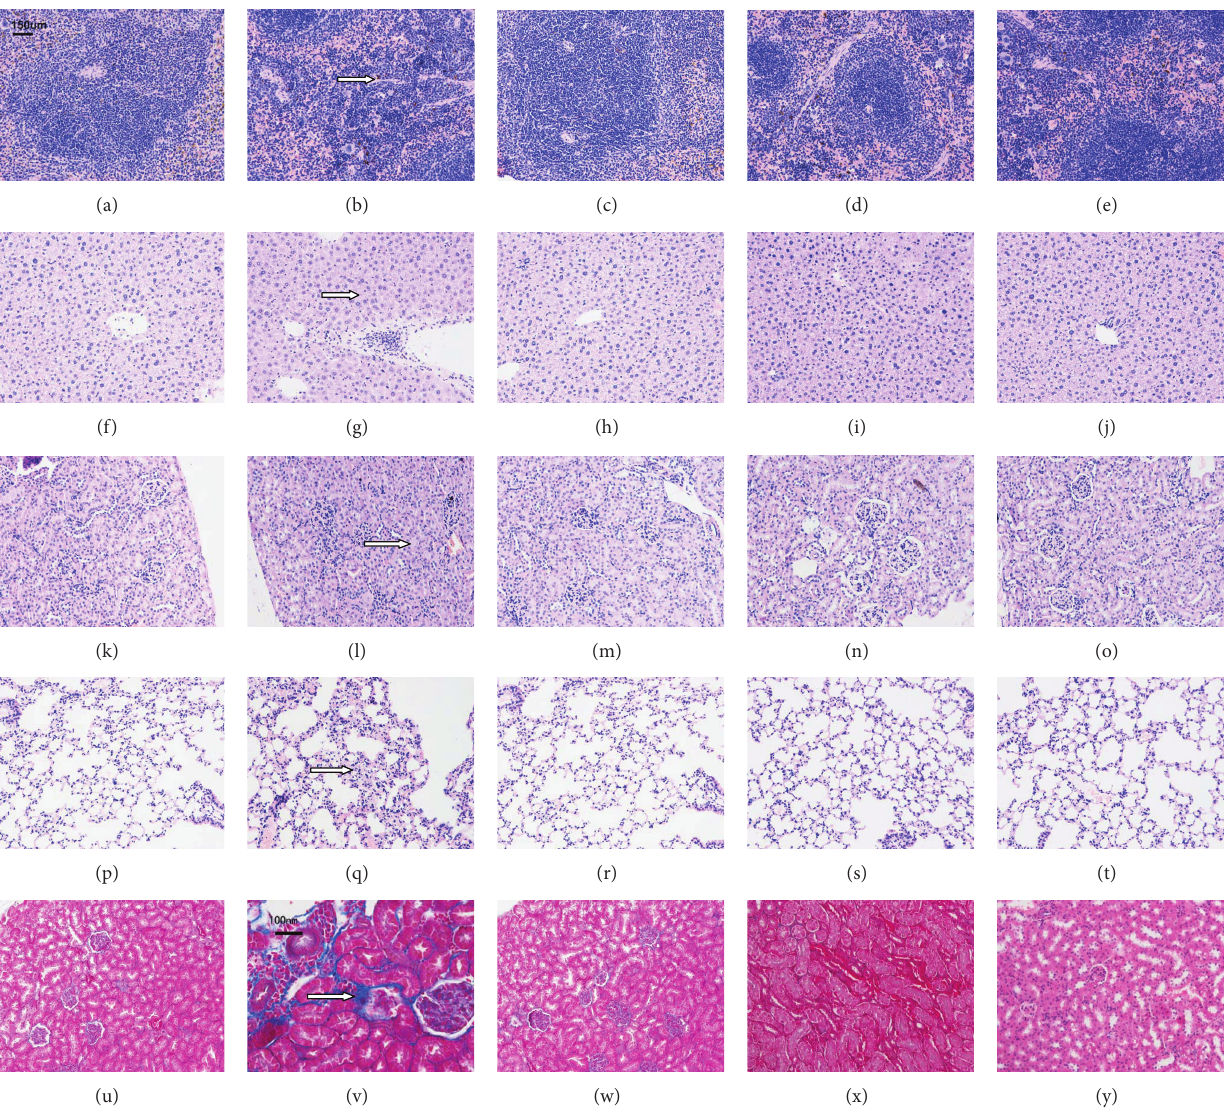
Figure 3: (a–e) Spleen H&E staining (200x magnification). (a) C57BL/6 mouse normal control group. (b) B6.Fas mouse model group.